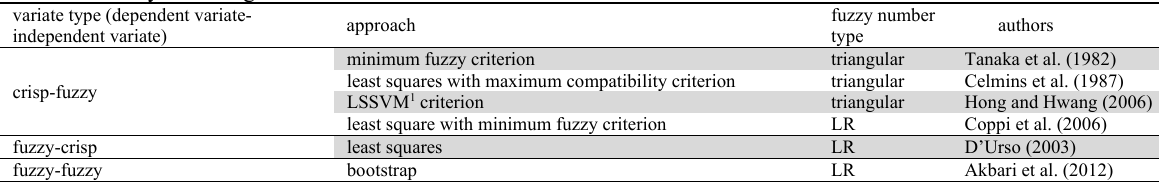
Review on fuzzy linear regression variate type (dependent variate- independent